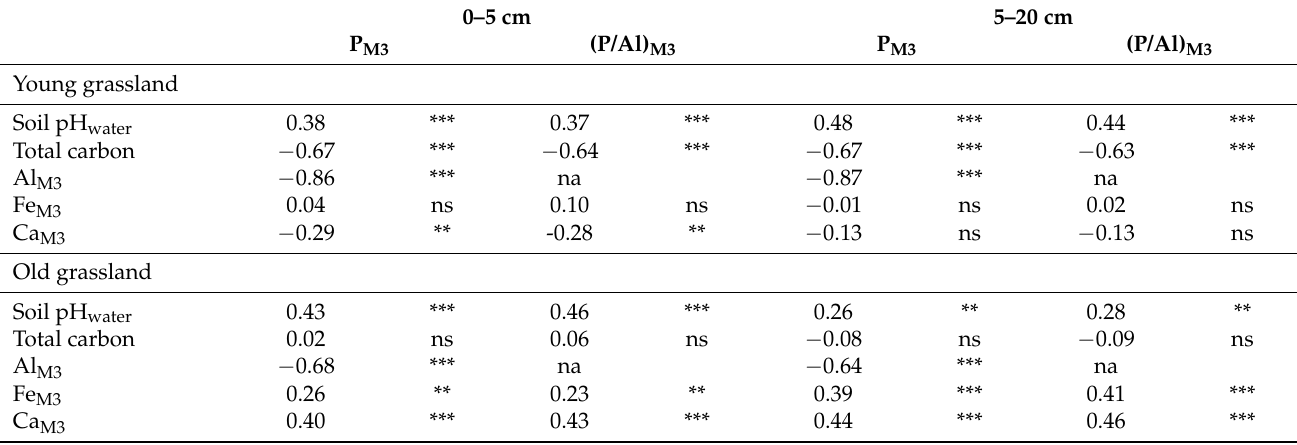
Table 3. Pearson’s correlation coefficients (r) of the soil-available phosphorus (P) indices (P M3 , and (P/Al) M3 in relationship with soil chemical properties for two soil layers (0–5 cm) and (5–20 cm) from the young and old grassland